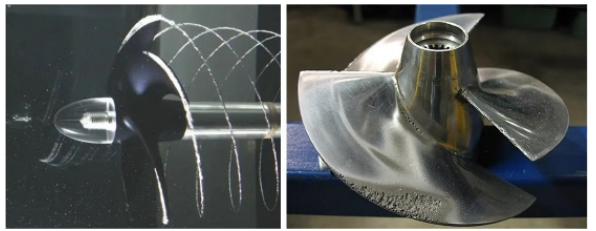
Figure 1. Cavitation erosion on propeller [20].